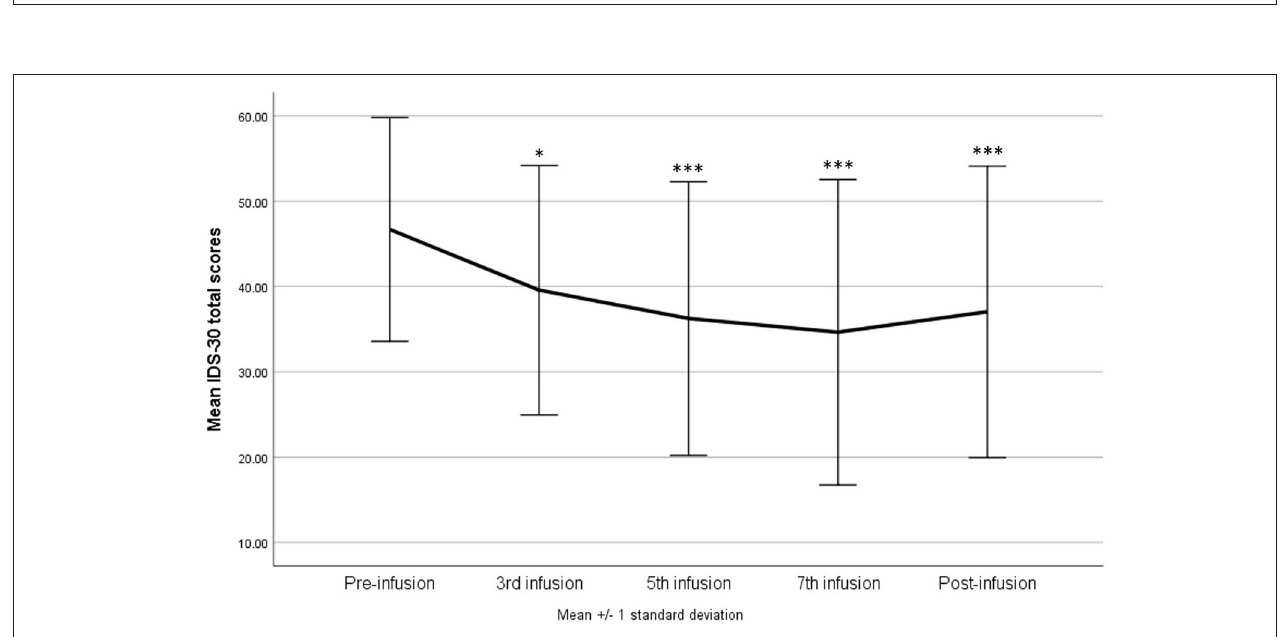
general level of depression is reduced due to a decrease in the symptoms of anhedonia. The change in the level of anhedonia explained 42% of the variance of the IDS-SR 30 score improvement. The results are in line with the existing evidence, although data on the effect of ketamine on anhedonia are